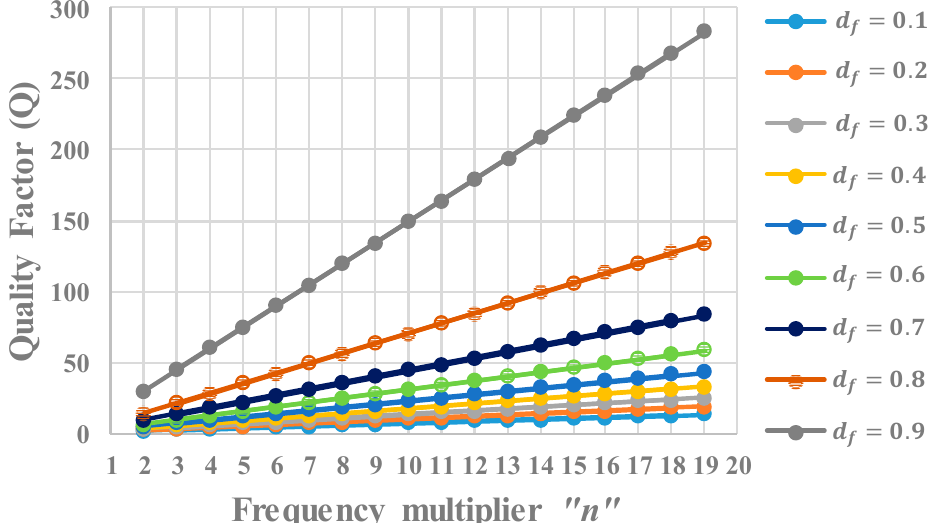
Figure 4. Quality factor with fixed damping factor “ d f ” for odd and even values of the multiplier “ n ”. ( d f = 0.1).